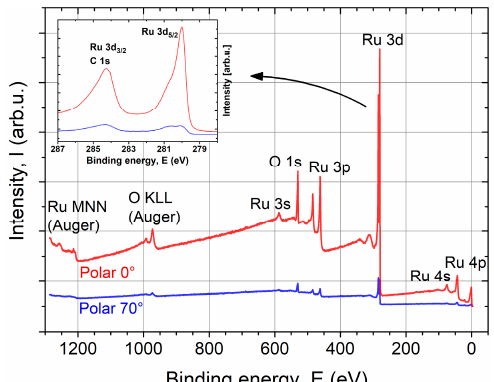
Figure 7. X-ray photoelectron spectroscopy (XPS) survey spectra of ALD Ru ( z = 57 nm) coating on a Si substrate at normal emission (0°) and a polar angle of 70° with indicated features. Only Ru and O were detected, with O mainly being present on the layer surface. The inset shows a zoom-in into the Ru 3 d state region.